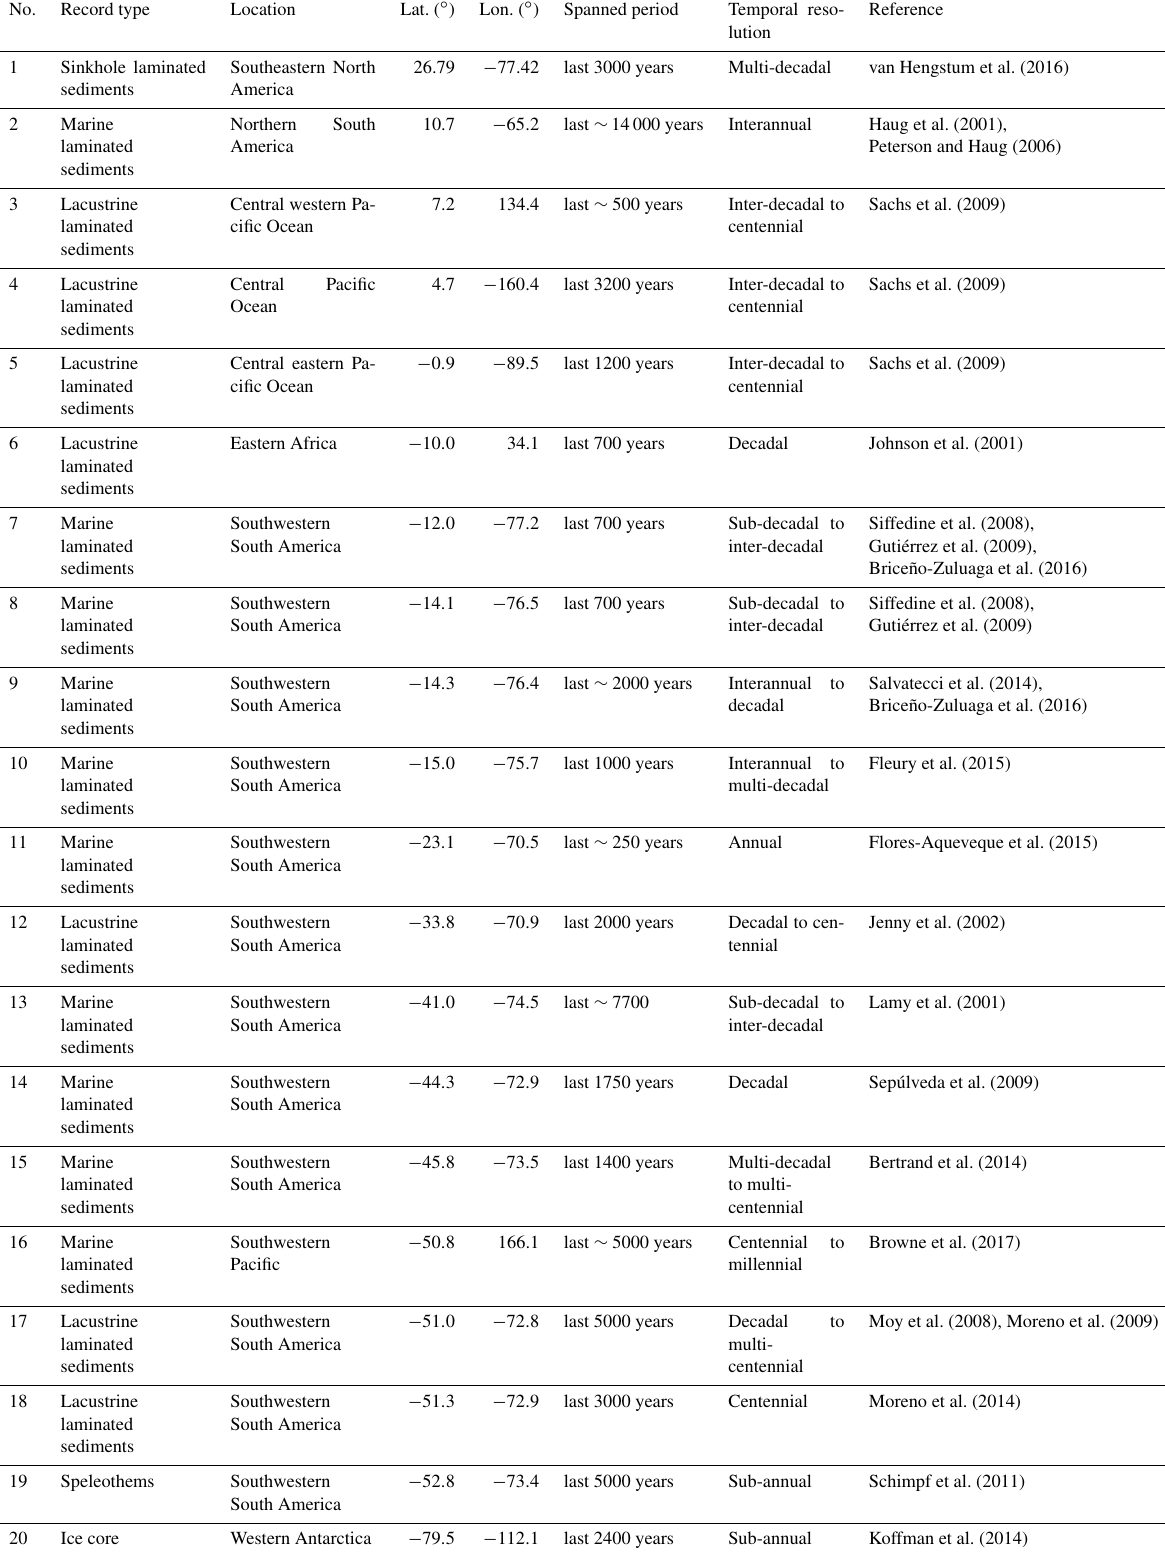
Table 2. List of paleoclimate and paleoenvironmental records from southern South America and other regions used in this work, along with their